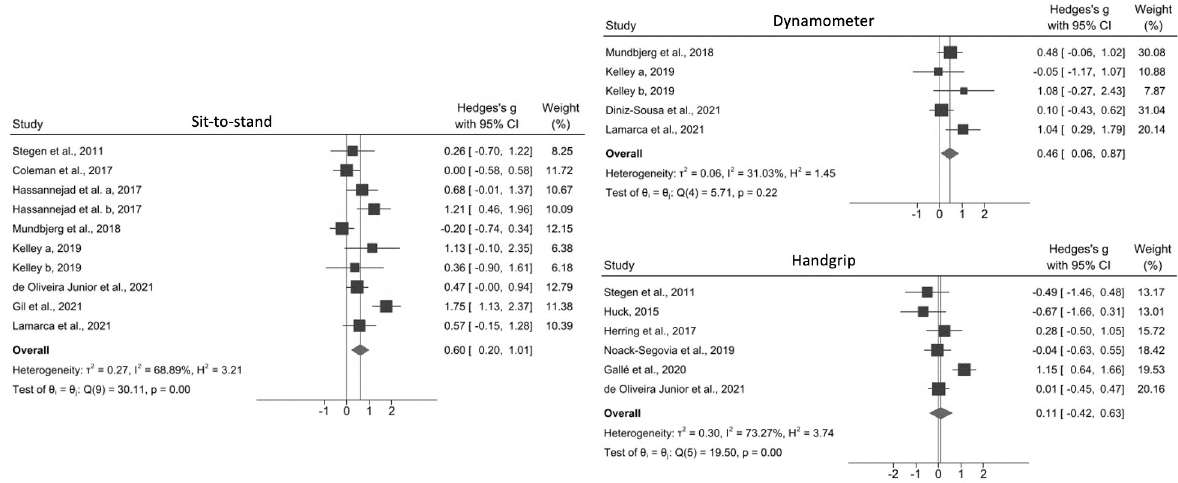
Fig 4. Effect size of physical exercise on muscle strength in adults following bariatric surgery according to the sit-to-stand, dynamometer, and handgrip tests. Hassanejad et al. a, 2017: aerobic training; Hassanejad et al. b, 2017: aerobic and resistance training; Kelley a, 2019: resistance eccentric; Kelley b, 2019: resistance